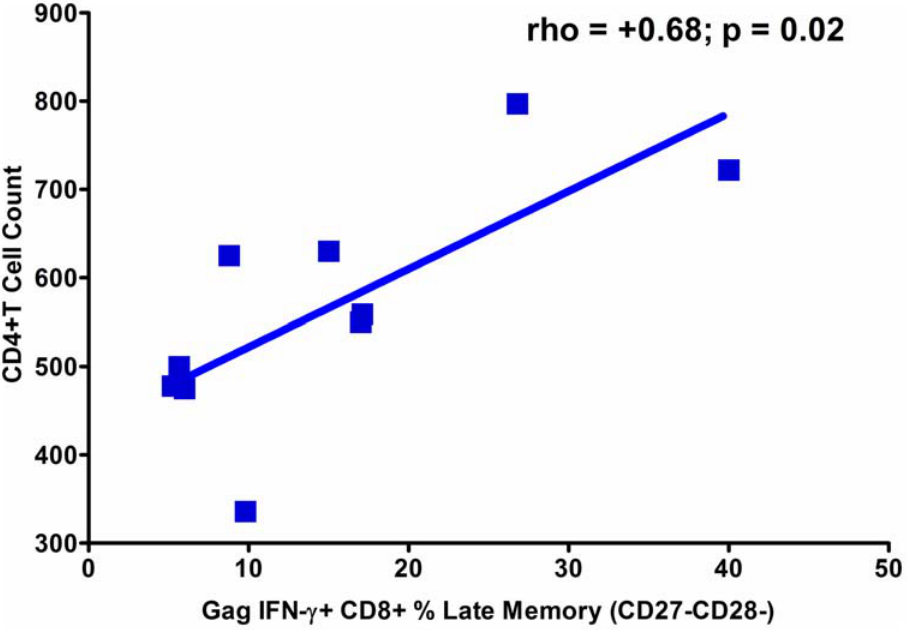
Figure 6. A More Differentiated Gag Specific CD8 + T Cell Response is Protective in Early HIV-1 Infection. Spearman Correlation results shown. Correlation performed on data from pre-treatment, Visit 1. Patients with higher CD4 + T cell counts during early infection and prior to anti- retroviral therapy tended to have higher HIV-1 Gag specific IFN- c late memory (CD27 2 CD28 2 ) CD8 + T cells